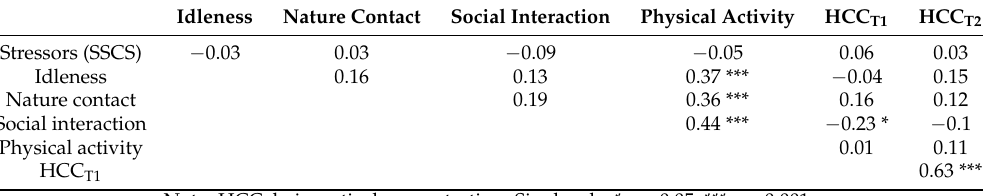
Table 3. Intercorrelations (Spearman’s ρ ) of the predictors and correlations with hair cortisol levels. Idleness Nature Contact Social